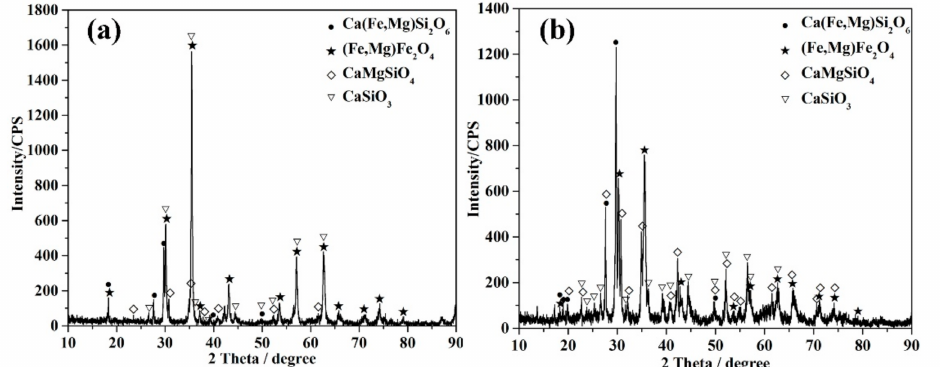
Figure 7. Effects of CaO content on the iron content, recovery rate, and yield of concentrate.